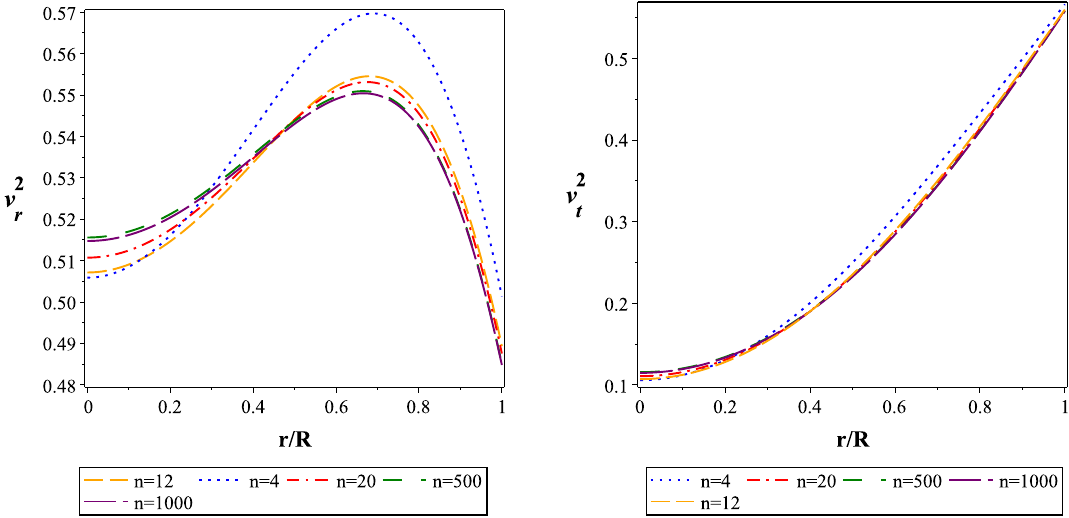
Fig. 3 Variation of the radial velocity v 2 r (left) and tangential velocity v 2 t (right) with respect to the radial coordinate ( r / R ). For purpose of plotting this figure , the numerical values of the constants for different parameters n are mentioned in Table